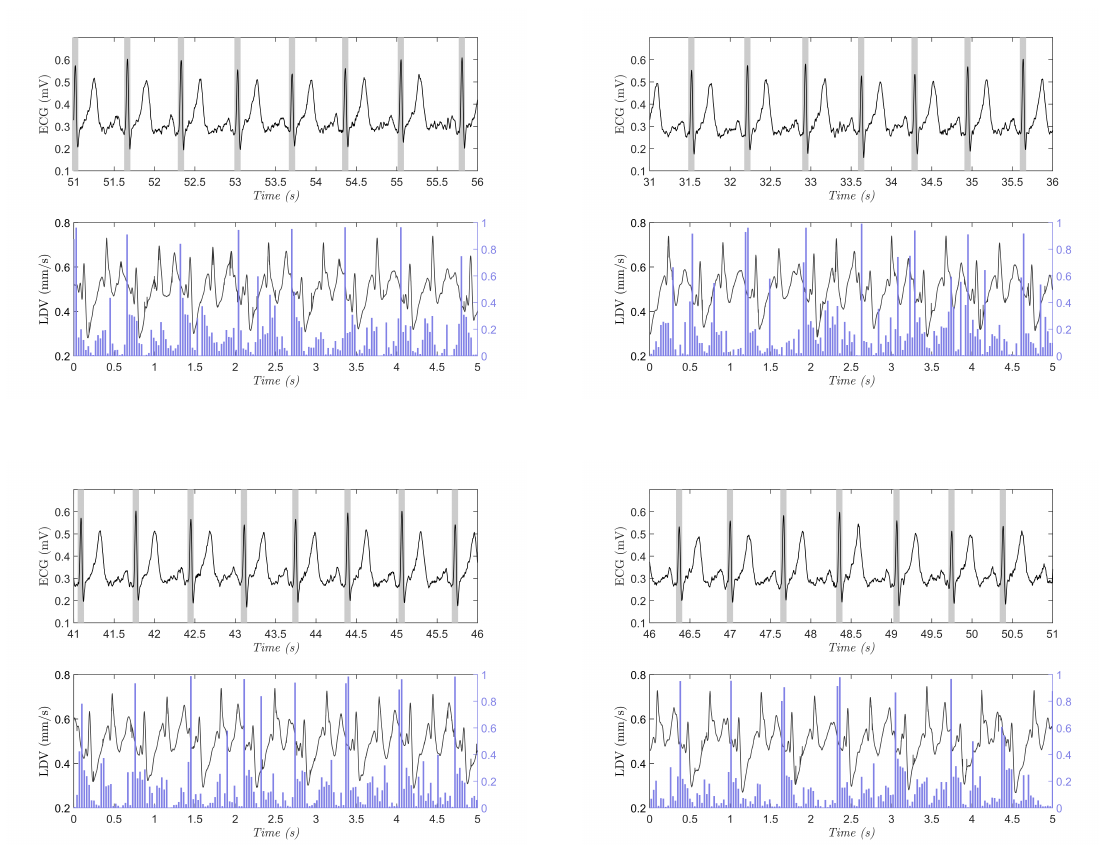
Figure 8. Four sample testing results on the full-length (10-min long), LDV signal (the signal was smoothed for visualization purposes only). In each subfigure, the ECG signal with gold-standard beats (grey rectangles centered with the R peak from the ECG), and the output probability (vertical blue line) for the beat class obtained with support vector machines are shown. The beats in the ECG signal are shown with rectangles for better visibility.